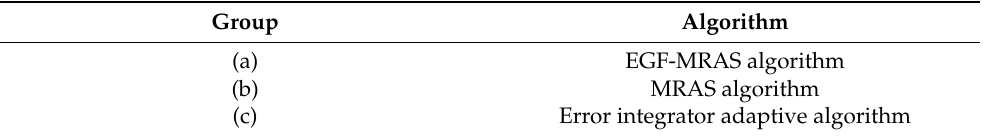
Table 8. Experiment groups of